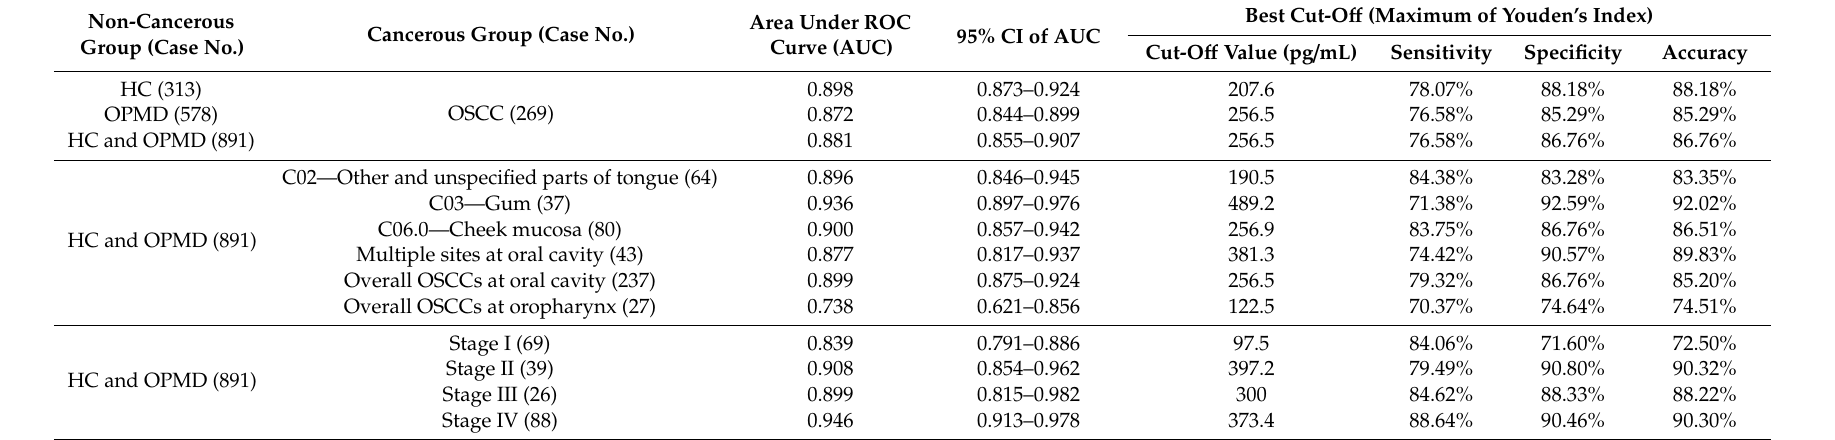
Table 2. Summary of ROC curve analysis between non-cancerous and cancerous